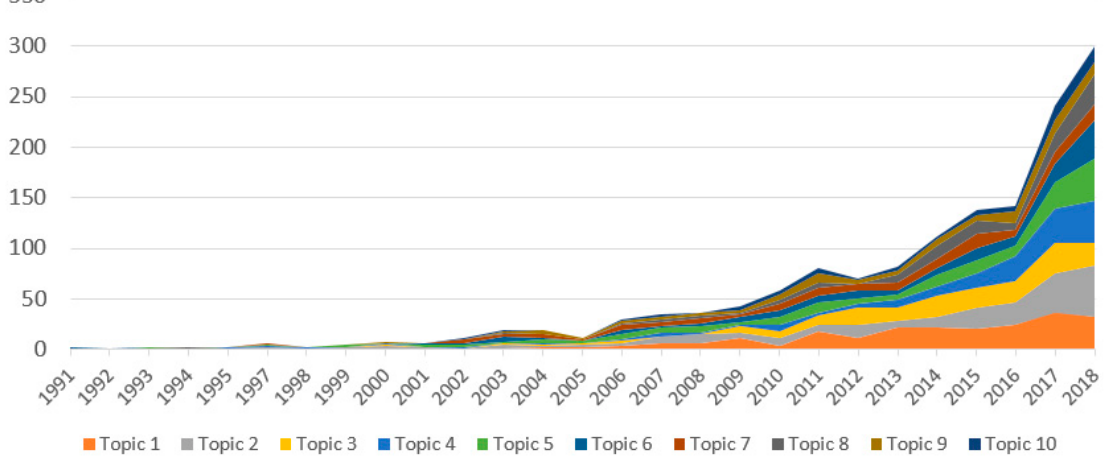
Figure 4. Changes in applications of AI to stroke and heart disease research during 1991–2018.